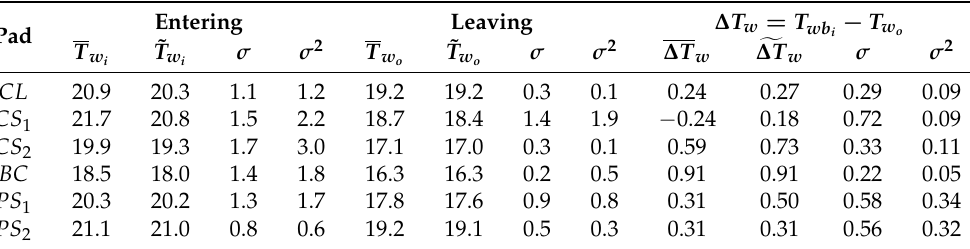
Table 6. Statistical analysis of the water temperature ( T w ) entering ( i ) and leaving ( o ) the pad in the wind tunnel tests. The difference between the inlet air wet-bulb temperature ( T wb temperature leaving the pad ( ∆ T w = T wb [ ◦ C], σ is the standard deviation [ ◦ C] and σ 2 is the variance [ ◦ C 2 ].